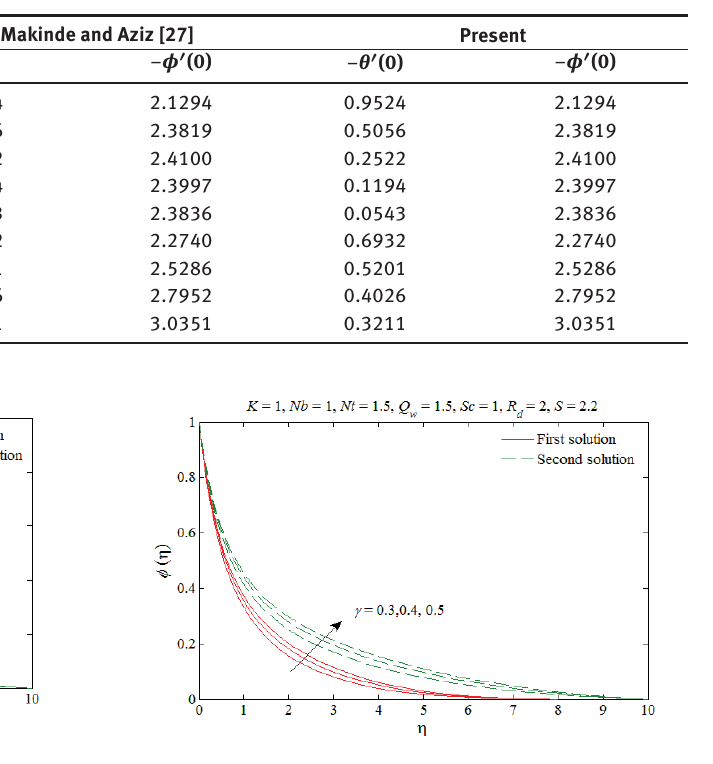
Fig. 9: The concentration profiles for different values of γ .